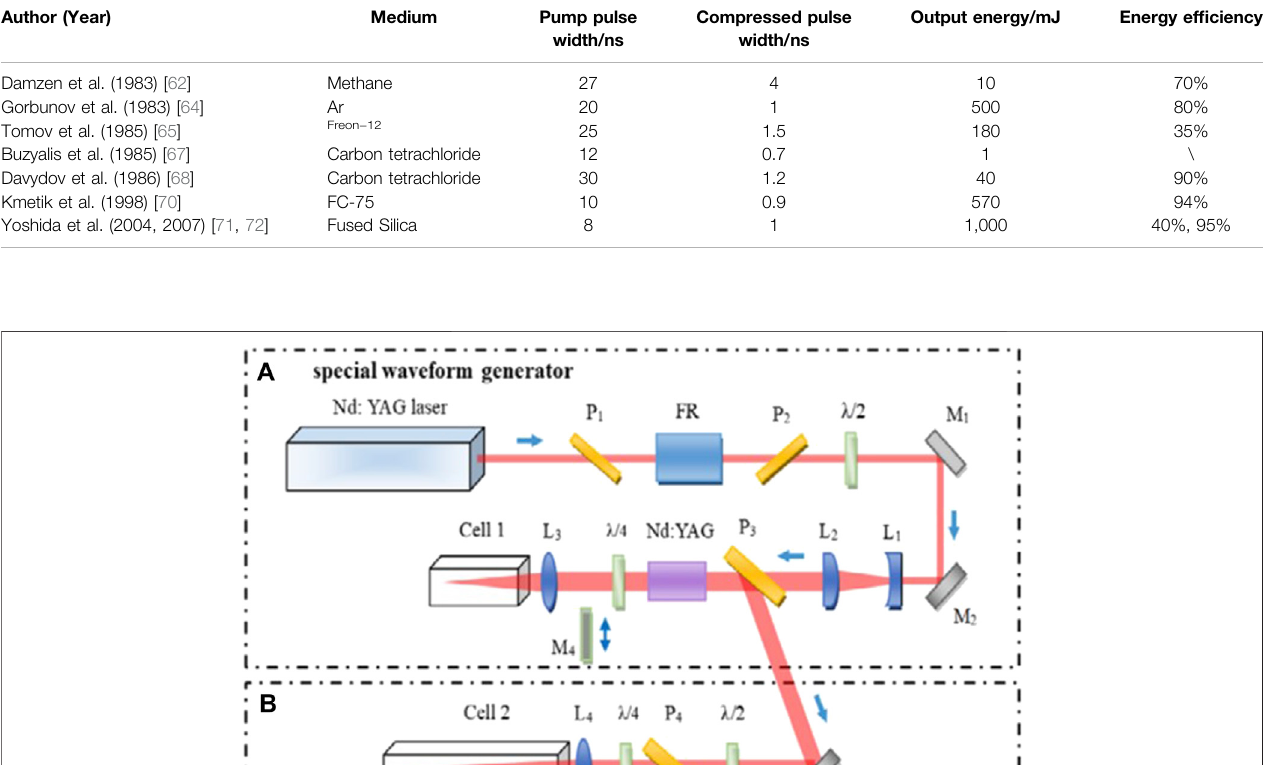
Frontiers in Physics |